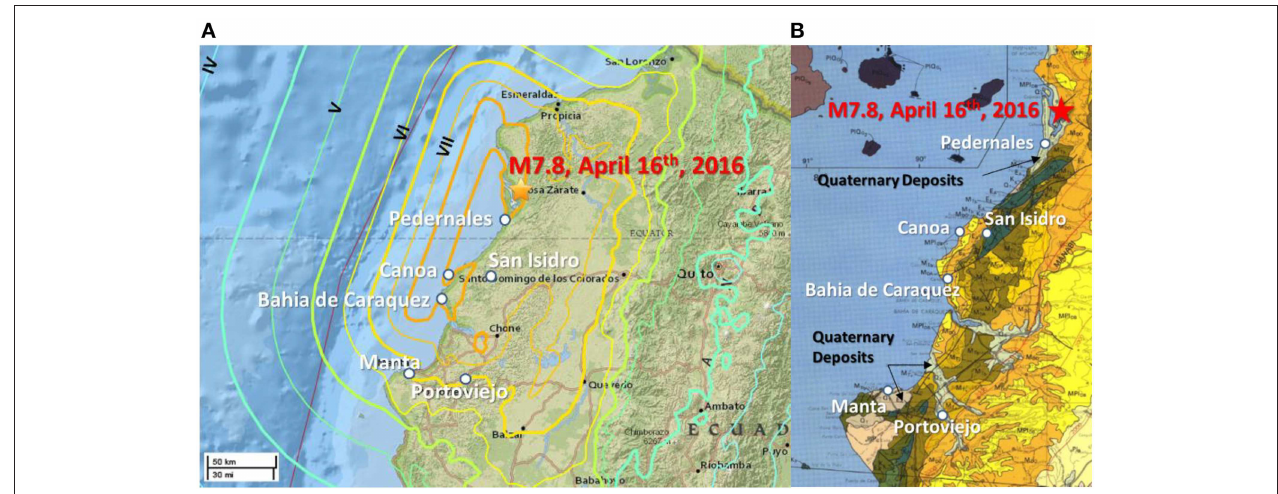
FIGURE 3 | Location and geological map of affected regions in Ecuador. (A) USGS Shake Map Intensities [United States Geological Survey (USGS), 2016]. (B) Geological map extract [after Dirección de GeologiÌ a y Minas (DGGM),